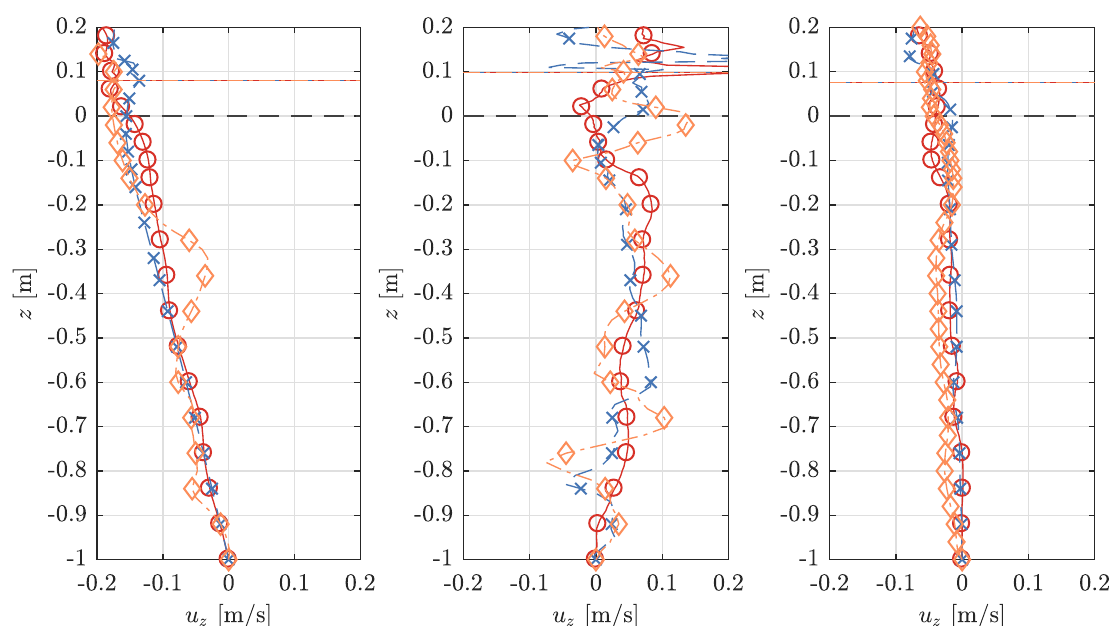
Figure 13. Velocity profiles in horizontal, u x , and vertical, u z , direction at the cylinder centre (WG B2), 0.5 m before (WG B1) and 0.5 m after (WG B3) the axis for a wave crest at the cylinder